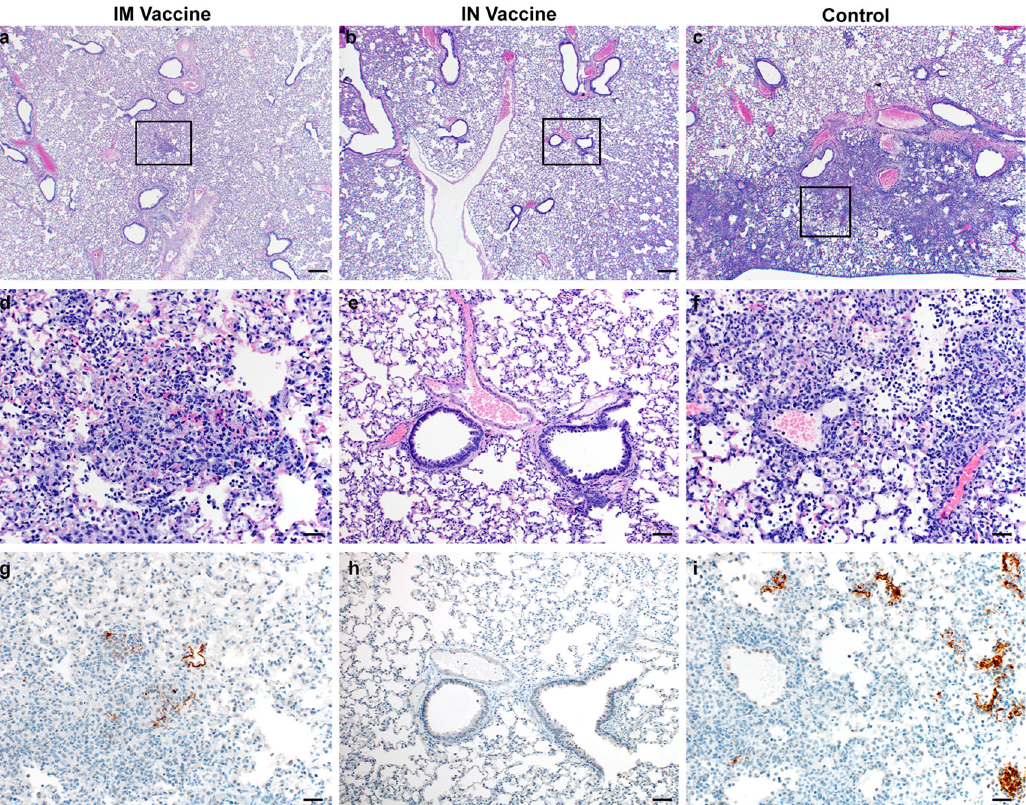
Fig. 7 Pulmonary effects of direct IN challenge with SARS-CoV-2 variant B.1.351 in Syrian hamsters which received an IN or IM vaccine at 5 DPI. a – c H&E 20x, scale bar = 200 µ m; a no pathology. b , c general prevalence of interstitial pneumonia. d – f H&E 200x, scale bar = 20 µ m; d No pathology e rare focus of interstitial pneumonia. f moderate interstitial pneumonia. g – i IHC staining against N protein SARS-CoV-2, 200x, scale bar = 20 µ m. g No viral antigen. h Rare foci of viral antigen in type I pneumocytes. i Viral antigen within the larger area of interstitial pneumonia in type I pneumocytes. Micrographs are representative of what was observed viewing 100% of a single 5 µ m section of the complete lungs containing all lobes for each of four